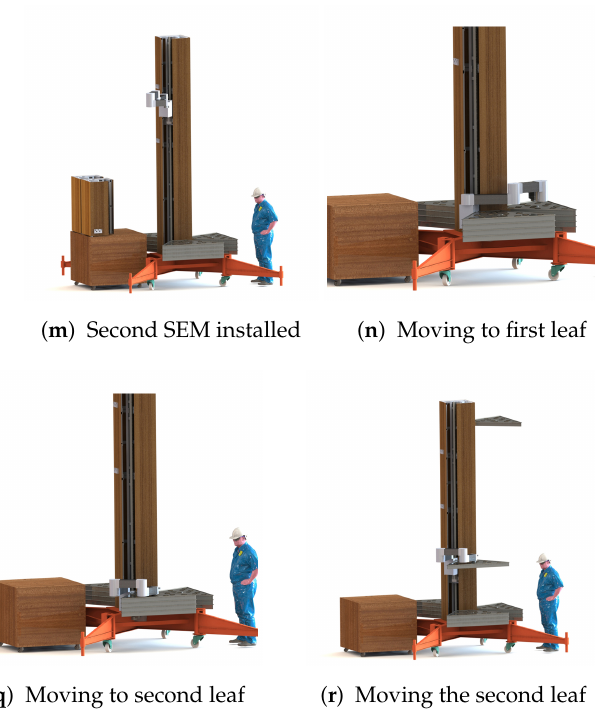
Figure 2. Stages of the self-assembly